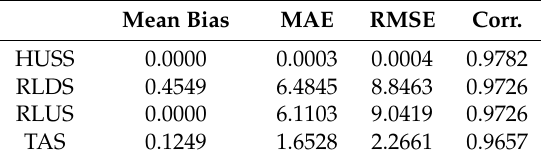
Figure 4. Averages of the correlation coefficients of Bayesian model averaging (BMA) ensemble for each month during 2006–2016. The correlation coefficients of all variables decreased in summer (May to August), particularly for RLDS. Table 5. Accuracy of BMA2 for the four input variables.